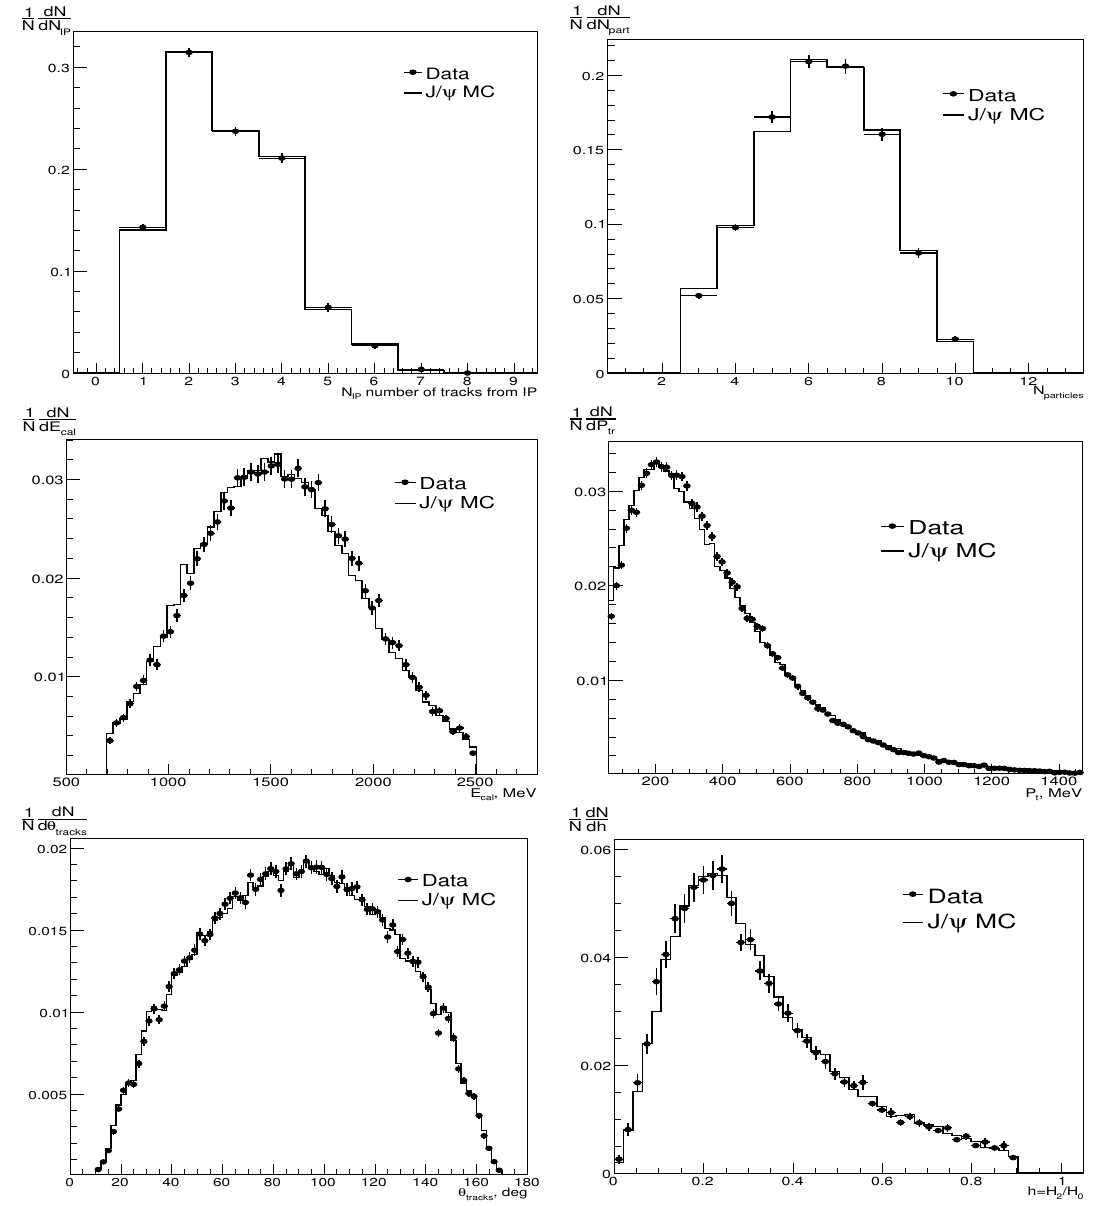
Figure 5 . Properties of hadronic events produced in the vicinity of the J= resonance: the number of tracks from the interaction point N IP , the total number of particles N part , energy deposited in the calorimeter E cal , inclusive P t and (cid:18) tracks distributions and the ratio of Fox-Wolfram moments H 2 =H 0 . The points represent experimental data, the histograms correspond to simulation of J= decays. All distributions are normalized to unity.